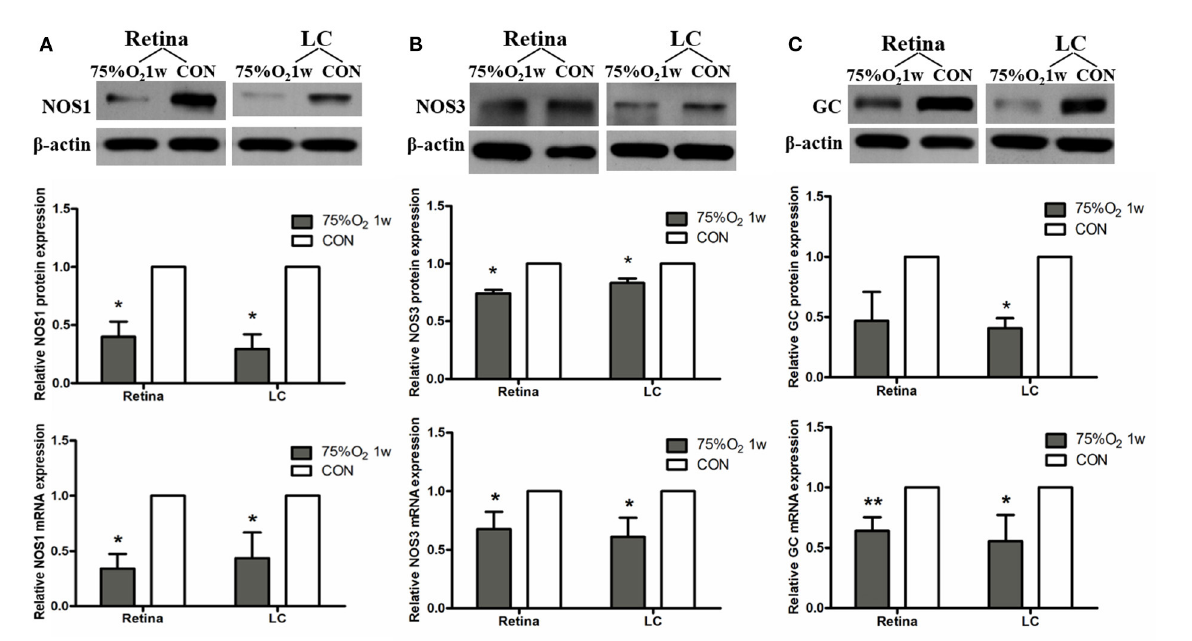
FIGURE6 Hyperoxia induced vasoconstriction in rat retina via down-regulation of NOS. (A) Protein and mRNA expression of NOS1 in retina and LC significantly decreased after 75%O 2 exposure for 7 days. (B) Protein and mRNA expression of NOS3 in retina and LC significantly decreased after 75%O 2 exposure for 7 days. (C) Protein and mRNA expression of GC in retina and LC significantly decreased after 75%O 2 exposure for 7 days. * p < 0.05, ** p < 0.01, LC, Lamina cribrosa; NOS, Nitric oxide synthase; GC, Guanylate